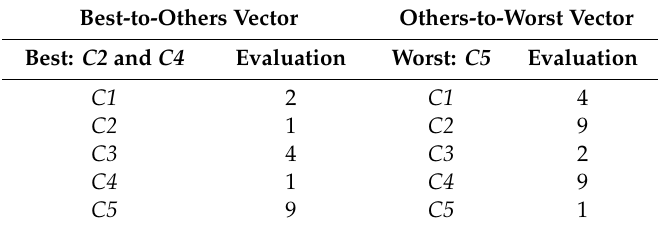
Table 1. The best-to-others and others-to-worst pairwise comparison